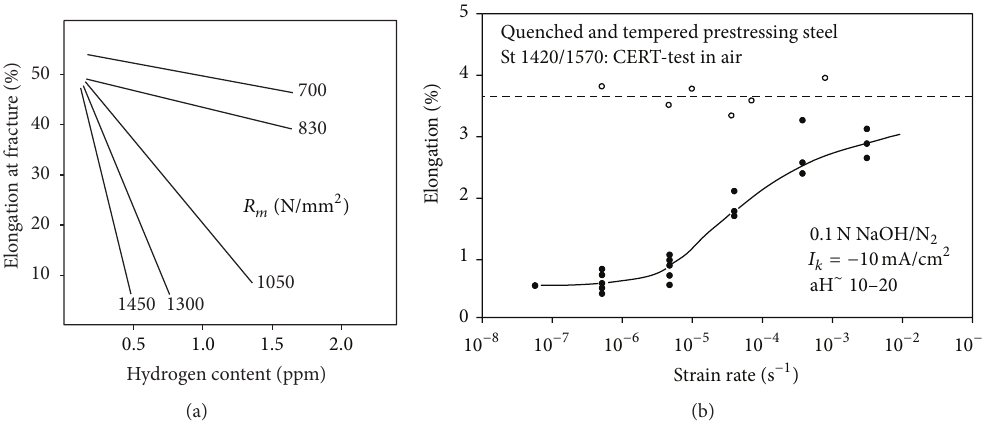
Figure 1: (a) Influence of H content on different steel types [24]; (b) influence of strain rate after H 2 -absorption on elongation [26].